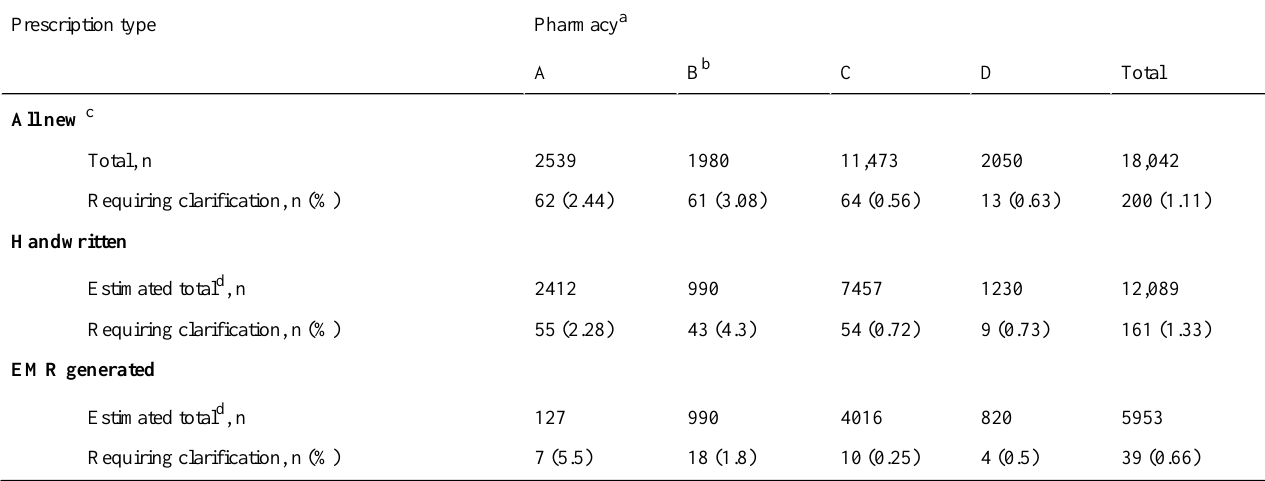
Table 2. Prevalence of clarification calls by prescription type.